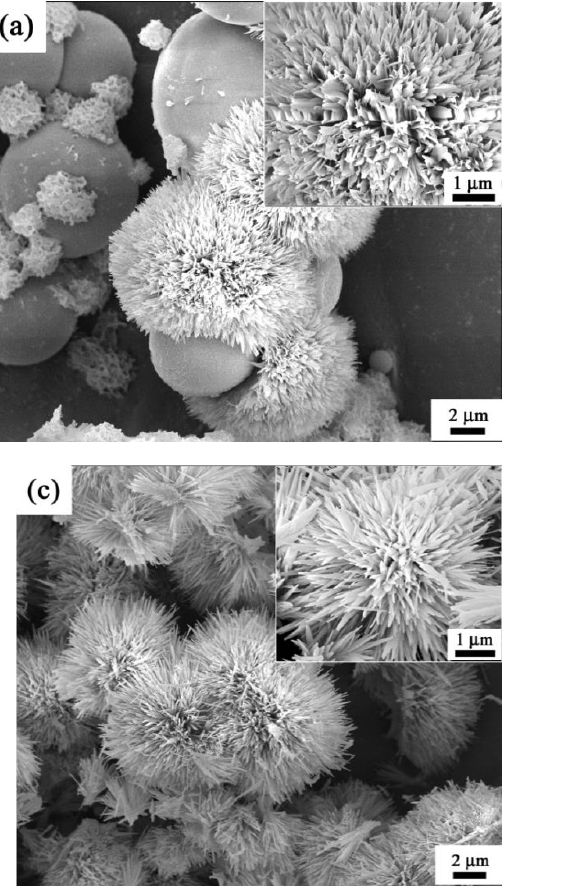
Figure 2. Scanning electron microscope (SEM) images of deposited precursors prepared by the hydrothermal method with different molar ratio of Al 3+ :CO(NH 2 ) 2 : ( a ) 1:3, ( b ) 1:5, ( c ) 1:6 and ( d ) 1:7.